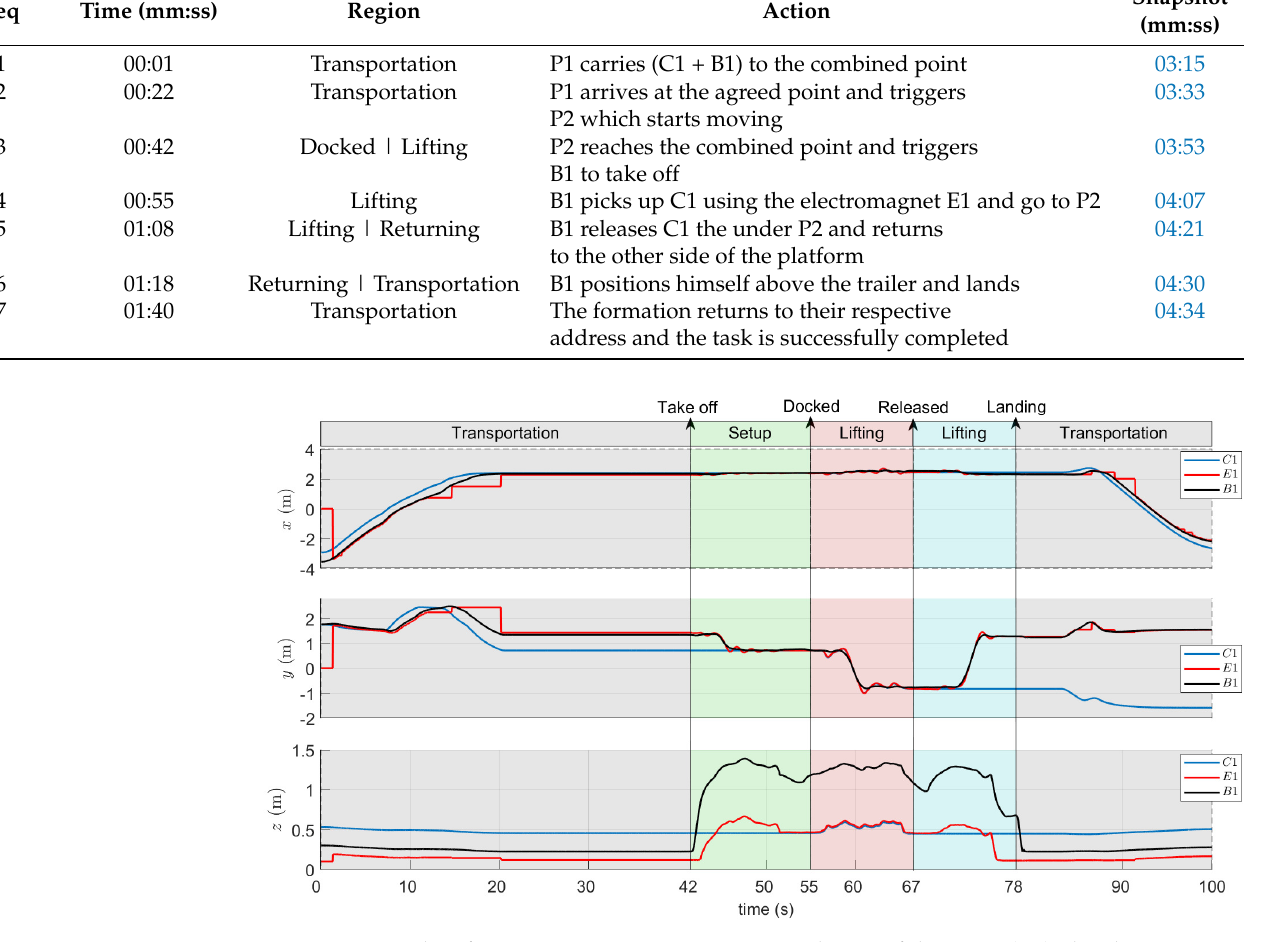
Figure 12. Results of Experiment #2. Position time evolution of the cargo (C1), the electromagnet effector (E1), and the Bebop UAV